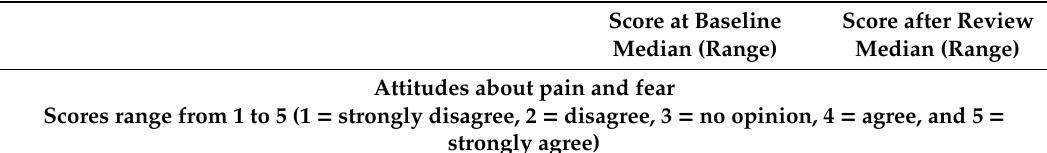
Table 2. Student attitudes about immunization and pain and fear before and after review of educational materials ( n = 7)